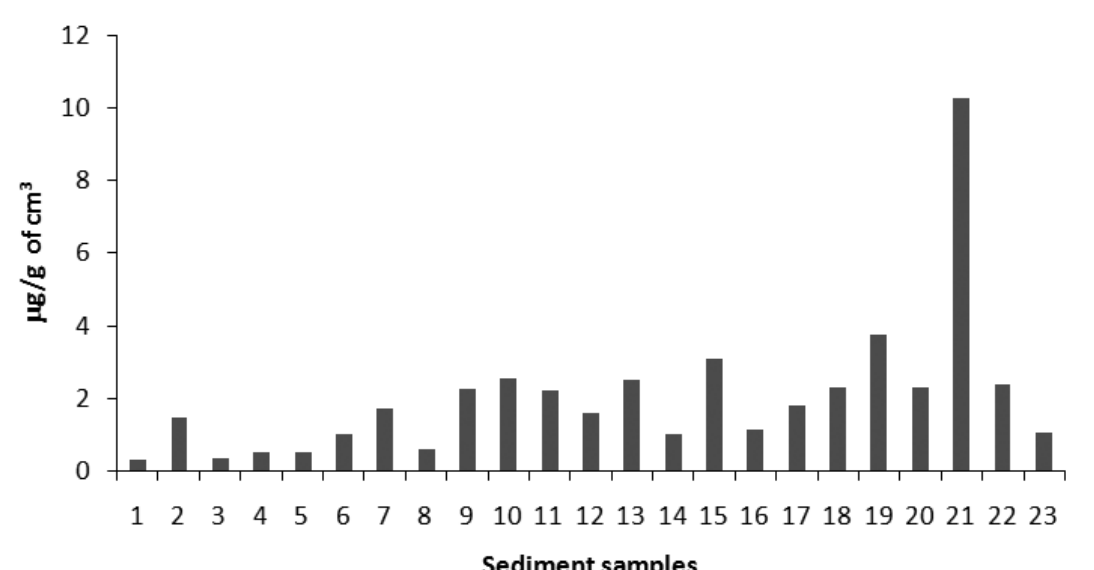
Fig. 5 – Total biopolymeric carbon concentrations.